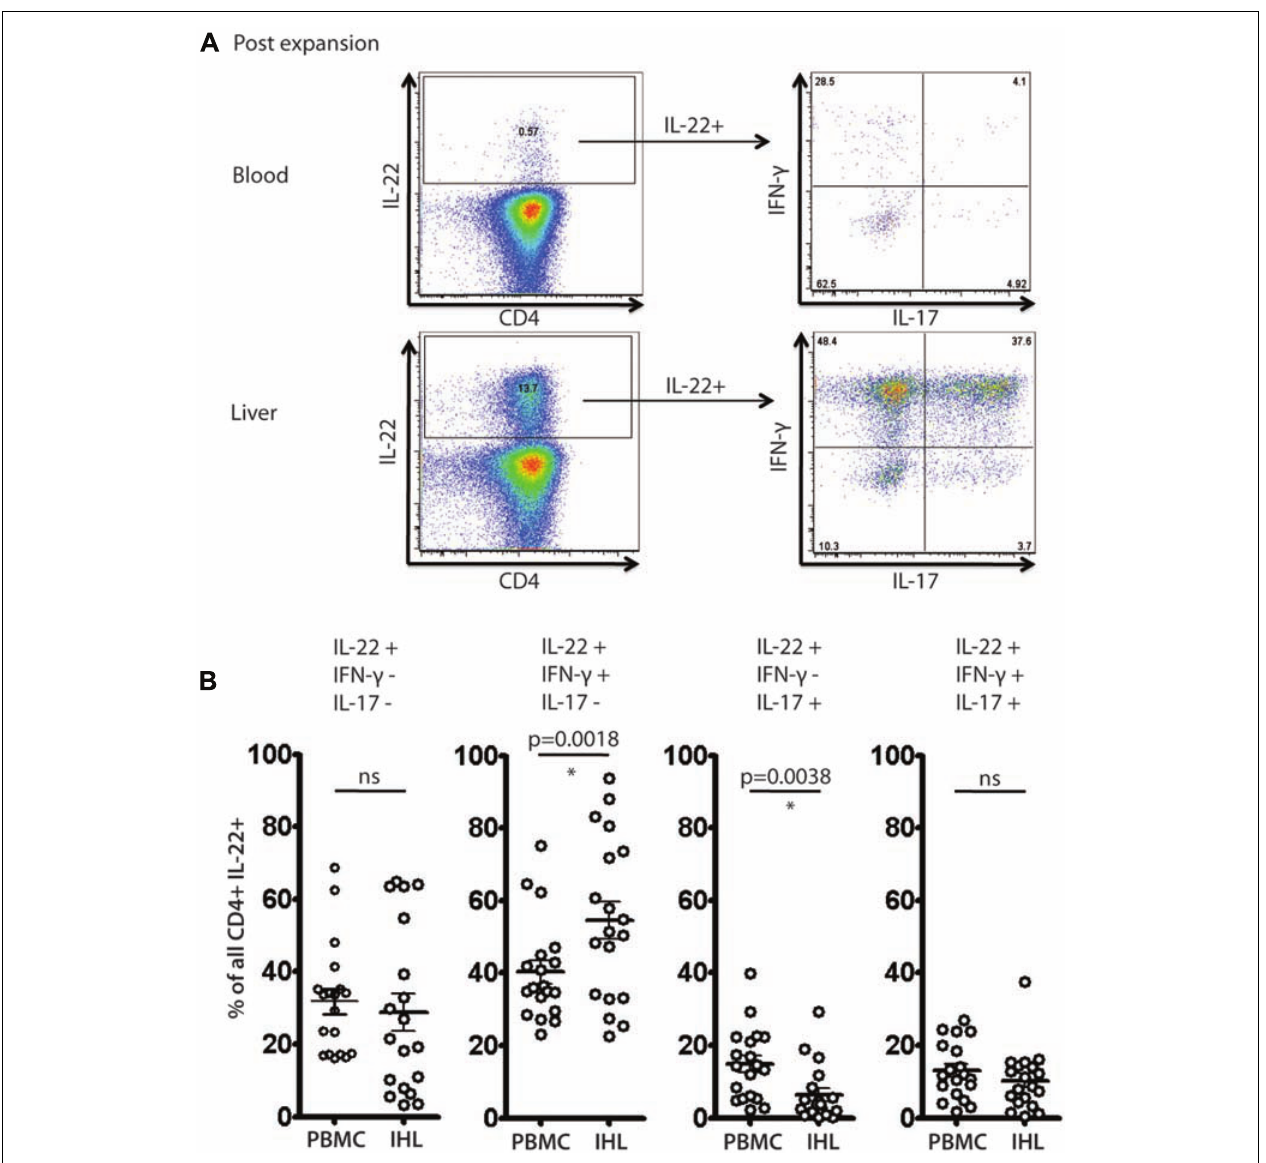
FIGURE 5 |Analysis of IL-22 secreting cells and polyfunctionality in blood and liver derived lymphocytes. Liver derived lymphocytes and PBMCs from HCV + donors expanded in vitro were analyzed in parallel for expression of cytokines IL-17A, IL-22 and IFN- γ in response to PMA/Ionomycin stimulation as described in methods. In (A) an example of staining is shown. IL-22 +